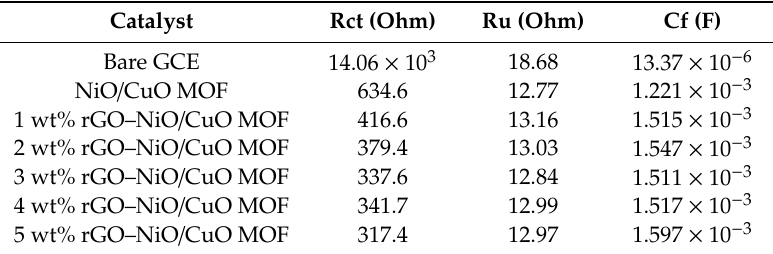
Table 4. Electrochemical parameters extracted from EIS data using bare modified electrodes in 3 M methanol and 1 M NaOH.